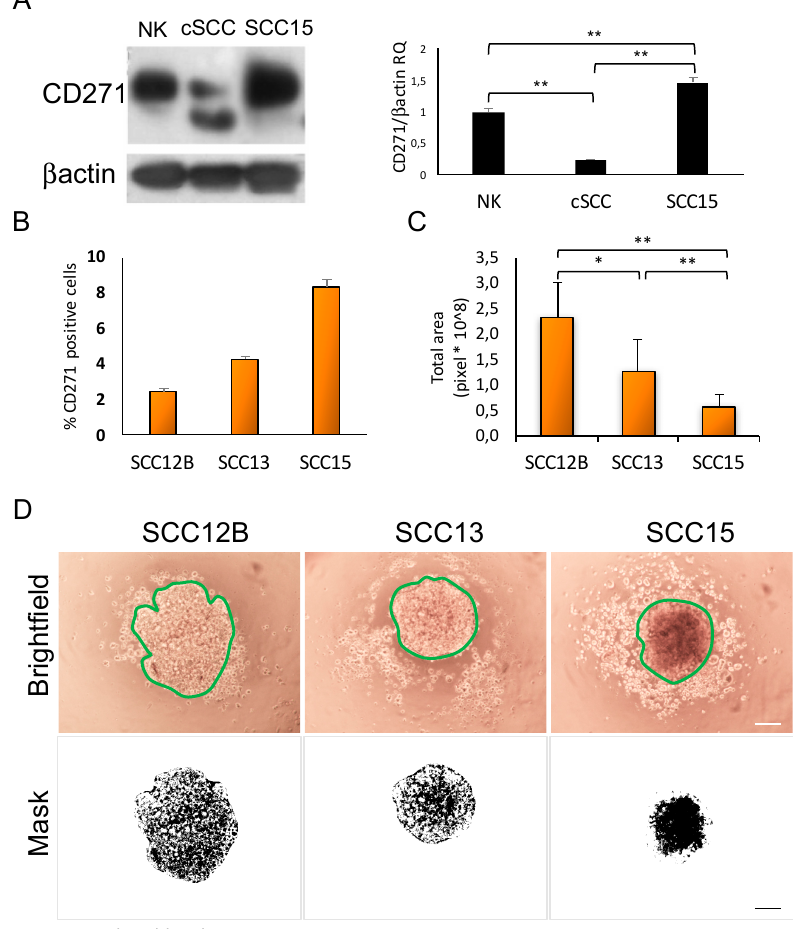
Figure 1. CD271 receptor expression in squamous cell carcimoma in vitro. ( A ) Left panel, CD271 expression in normal human keratinocytes (NK), keratinocytes from primary squamous cell carcinoma (SCC), and SCC15 cell line (SCC15) by Western blotting. Right panel, CD271 / β -actin RQ (relative quantification) by densitometry analysis performed by ImageJ software. ( B ) Percentage of CD271 positive cells in SCC12B, SCC13, and SCC15 cell lines evaluated by FACS analysis. ( C ) Total area (or spheroid size) of SCC cell line derived spheroids, evaluated by ImageJ software analysis at 24 h after SCC cell plating. ( D ) Upper panel: representative images of SCC12B, SCC13, or SCC15 derived spheroids. Scale bar = 100 µ m. Lower panel: SCC12B, SCC13, or SCC15 image masks generated from ImageJ software analysis and used to calculate the total area / size of each spheroid. For all results, data represent the mean from three independent experiments ± SEM. * for p < 0.05, ** for p <